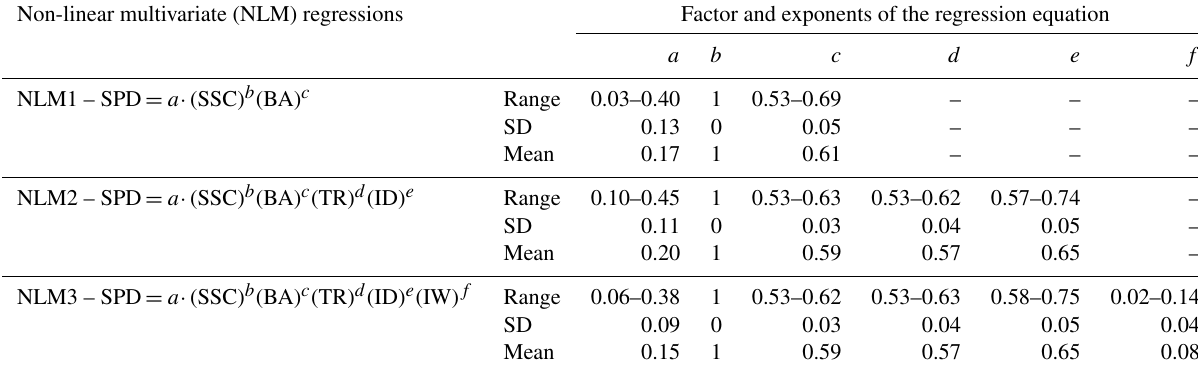
Table 5. The range and standard deviation (SD) of the parameters of NLMs. Note that exponent b was fixed to 1. Non-linear multivariate (NLM) regressions Factor and exponents of the regression equation